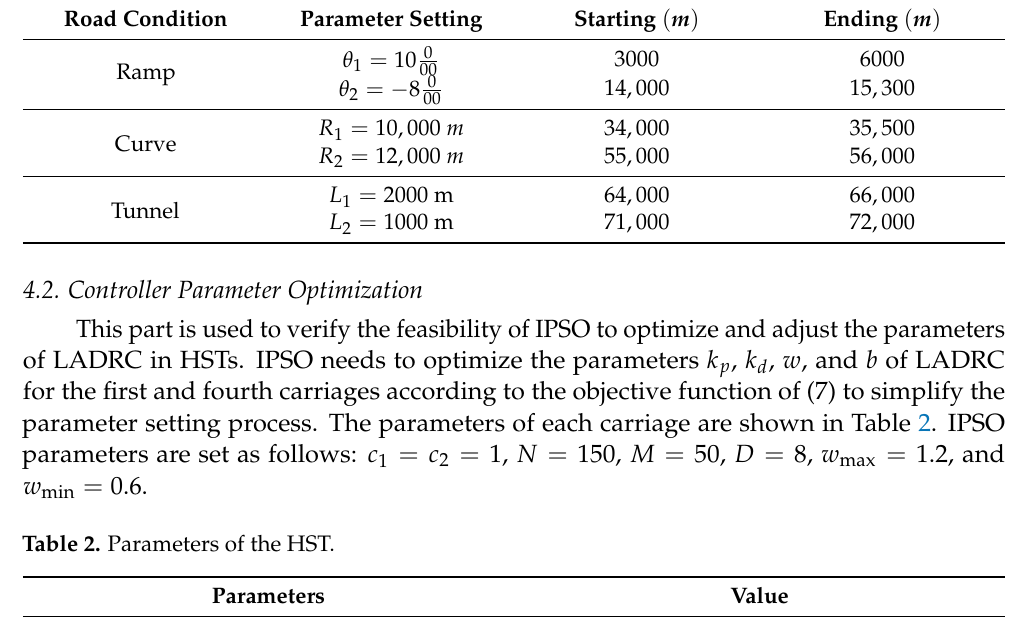
Table 2. Parameters of the